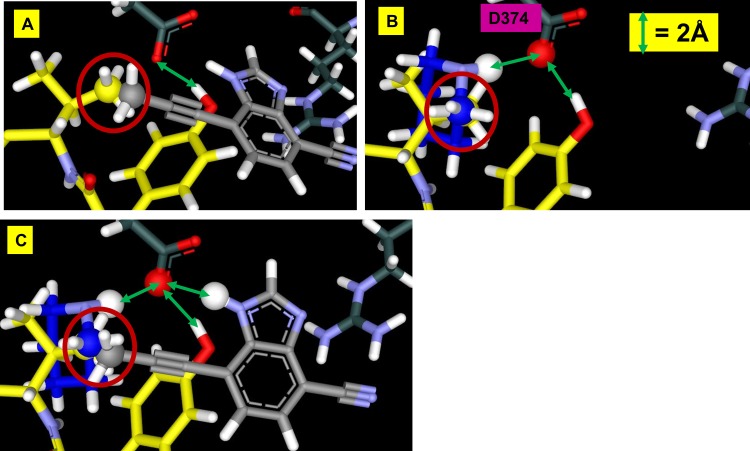
An acetylene linker is added to cyano-benzimidazole.A trial custom fragment was designed (A) and SACP confirmed that it tightly bound in the same mode as the original smaller fragment with the terminal carbon of the acetylene moiety occupying the same space as a terminal carbon of LDLR-Val307 (red ring). The piperidine fragment (B) binds with its carbons overlapping the side chain carbons of LDLR-V307 and pointing its N to form an H-bond with PCSK9-D374 and thus the two fragments (C) merge at LDLR-Val307 eliminating the error-prone linking process.